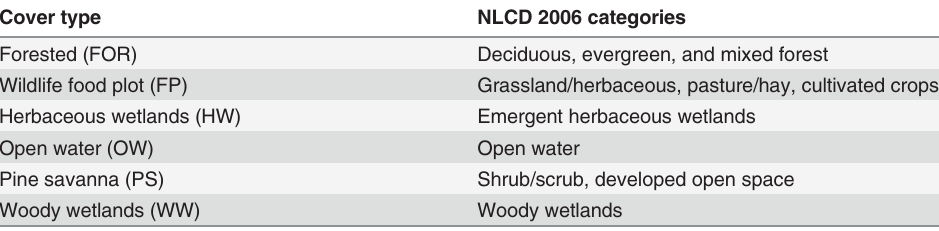
Table 1. Cover types (derived from 2006 National Land Cover Classification categories) for eastern di- amondback habitat selection analyses in the South Carolina Coastal Plain tidewater